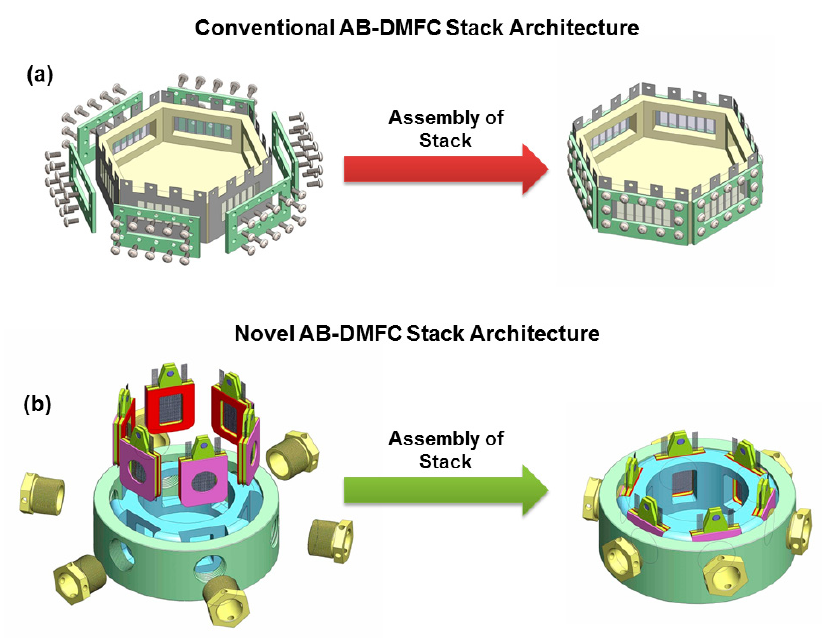
Figure 10. Comparison showing the fuel cell assembly of ( a ) conventional 6-cell DMFC stack (recreated from [122]), and ( b ) the novel 6-cell AB-DMFC architecture proposed by Abraham et al. Reprinted with permission from [71].